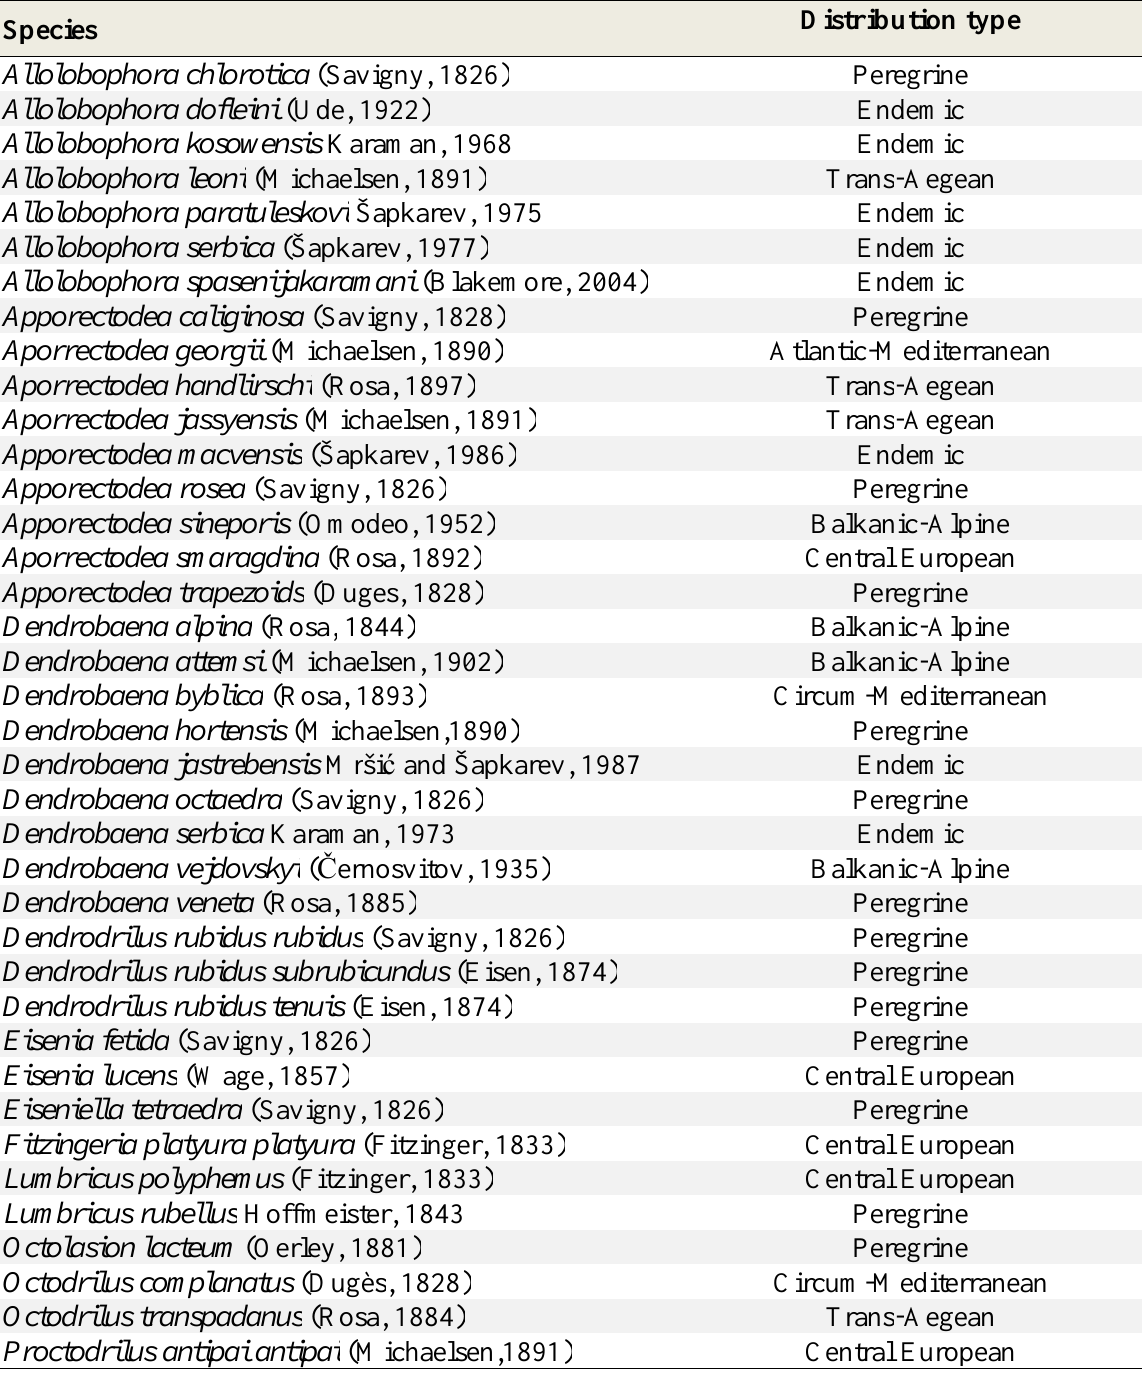
Table 1. List of the earthworms taxa with distribution